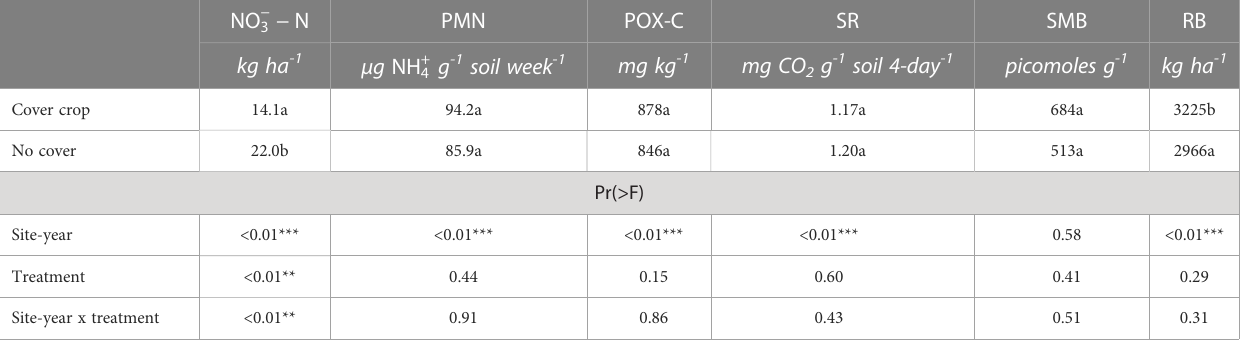
TABLE 2 Mean values of selected soil health indicators such as soil nitrate-nitrogen ( NO 3 N ; kg ha -1 ), potentially mineralizable nitrogen (PMN; µg NH